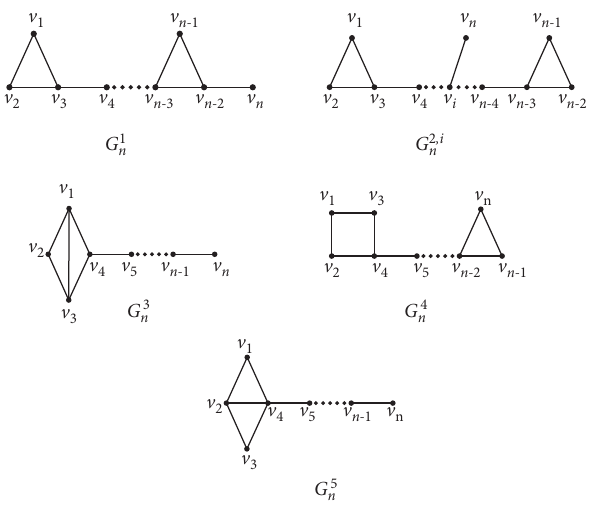
, G 2 ,i , G 3 ,G 4 n n n n , and